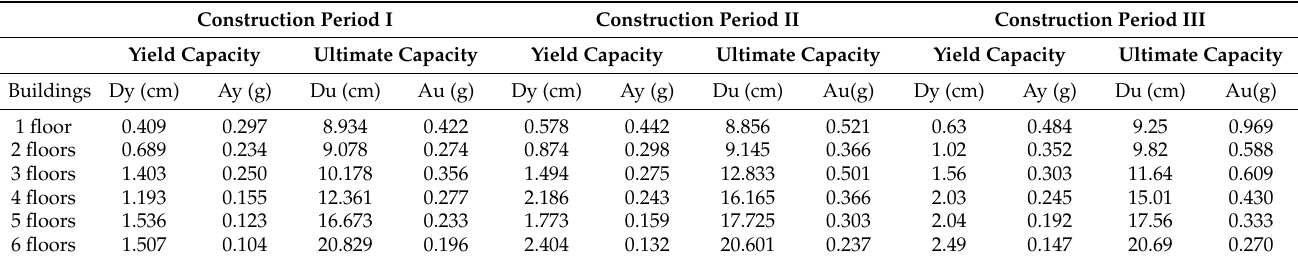
Table A1. Yield and ultimate capacity for buildings with seismic code.